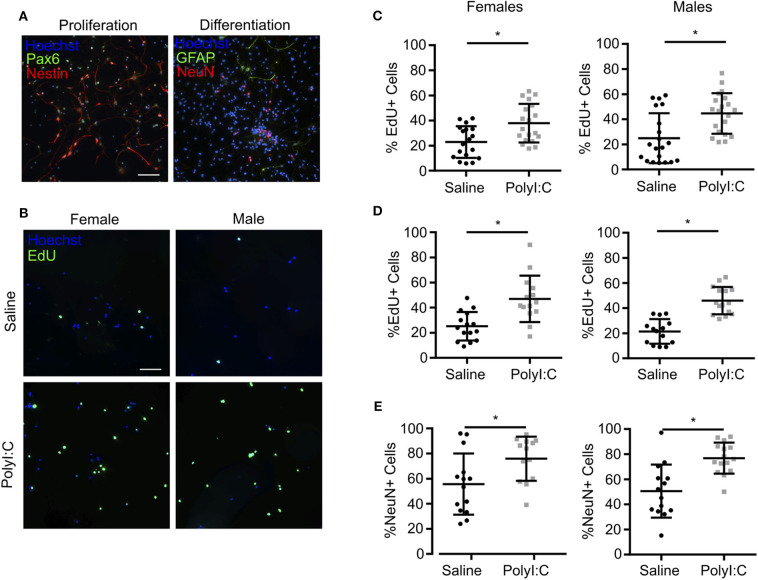
NPCs isolated from fetal cortices challenged prenatally with PolyI:C exhibit increased proliferation potential. Pregnant rats were administered saline or PolyI:C on E8.5, and NPCs were isolated from E15.5 cortices for neurosphere culture. Neurospheres from male or female embryos were pooled, and then mechanically dissociated to form monolayers. Monolayers were subsequently cultured in media to promote stem or differentiated states. (A) Representative images of NPC monolayers cultured in proliferation conditions stained for Pax6 (green) and Nestin (red), or cultured in differentiation conditions stained for GFAP (green) and NeuN (red). Hoechst (blue) was used to counterstain nuclei. (B) Representative images of EdU incorporation in NPCs prepared in proliferation conditions from male and female cortices challenged prenatally with saline or PolyI:C 1 week prior. (C) Percentage of male and female NPCs that incorporated EdU during culture in proliferation conditions. (D) Percentage of male and female NPCs maintained in differentiation media that incorporated EdU. (E) Percentage of male and female NPCs maintained in differentiation media immunoreactive for NeuN indicating their differentiation capacity. Statistical analyses were performed using Student's t-test. Data are represented as mean ± SEM. Data significantly different (P < 0.05) from controls are indicated by an asterisk (*2–3 fetuses per sex collected from at least 3 dams). Scale bar = 50 μm.